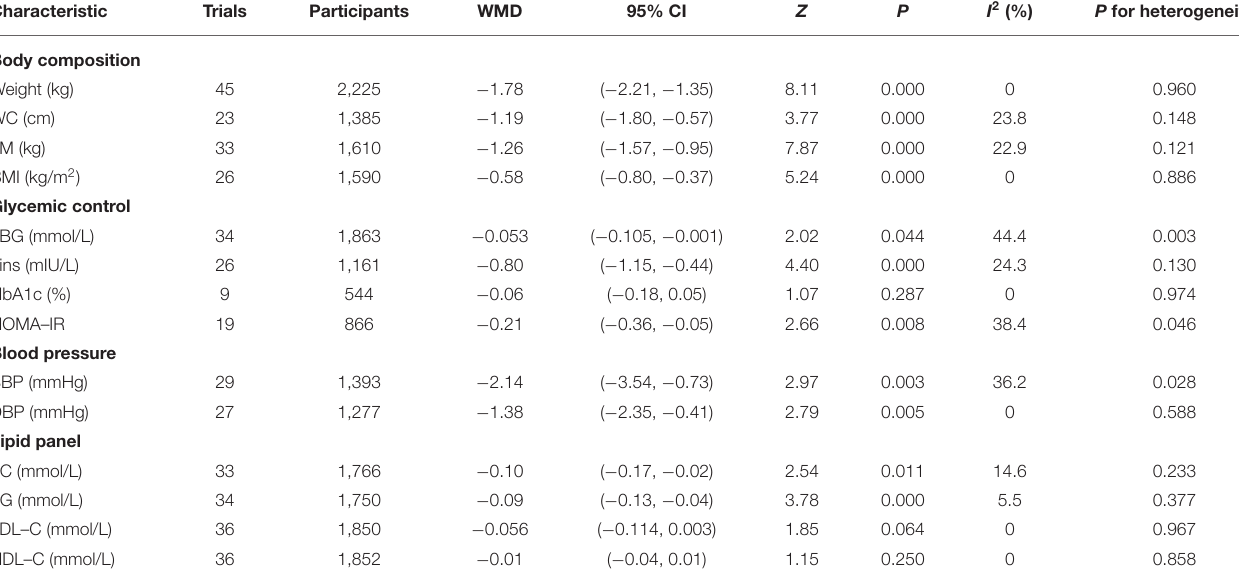
TABLE 2 | All the results calculated using Stata. Characteristic Trials Participants P for heterogeneity Body